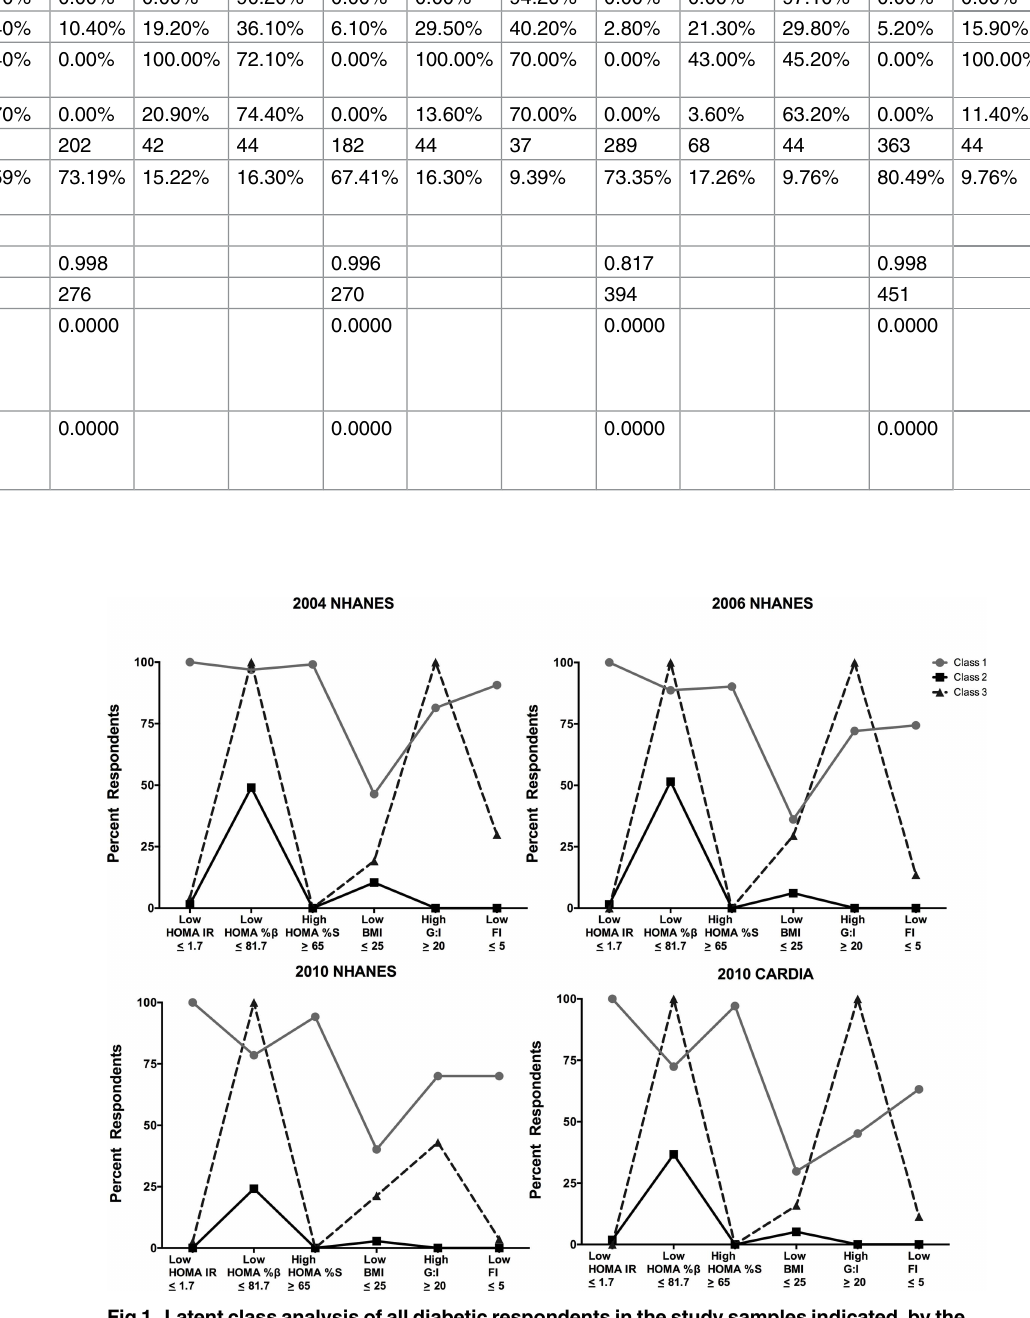
Fig 1. Latent class analysis of all diabetic respondents in the study samples indicated, by the diabetes correlateson the X-axis: National Health and Nutrition Examination Survey (NHANES)and the Coronary Artery Risk Development in Young Adults survey